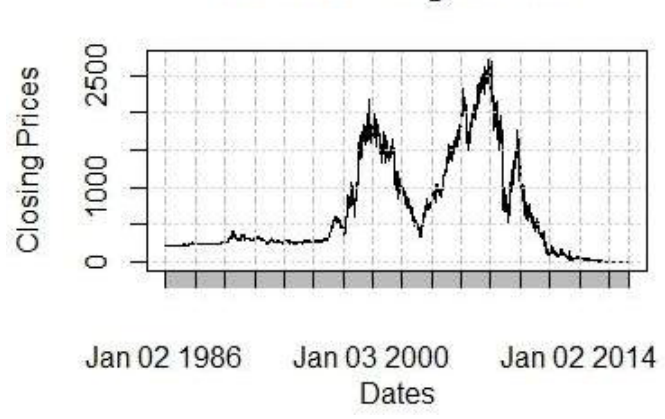
Figure 1. National Bank of Greece (NBG) closing prices (1986–2017).